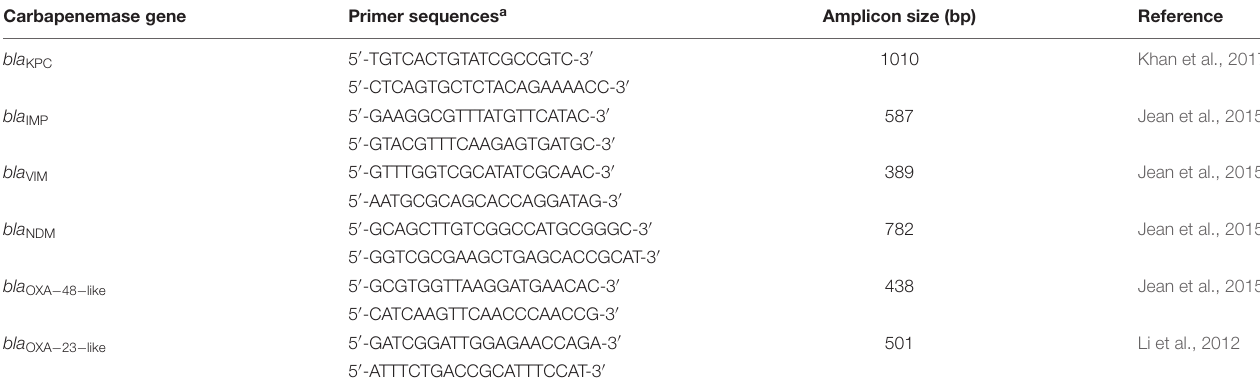
TABLE 1 | Primers for the detection of carbapenemase-producing Enterobacteriaceae. Carbapenemase gene Primer sequences